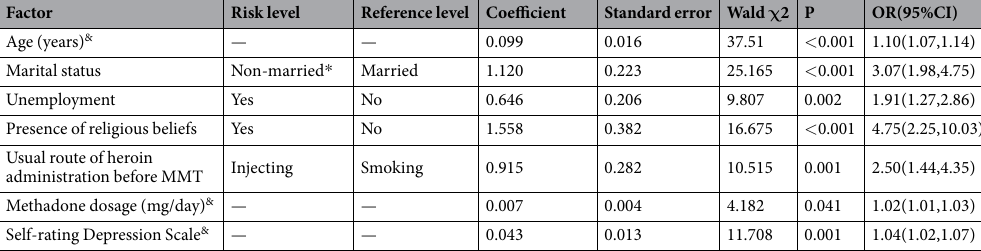
Table 2. Multivariate logistic regression results of factors significantly associated with clinically significant pain. & Continuous variables, the ORs for 1 unit increase in age (a year), methadone dose (1 mg/day), and Self-rating Depression Scale score (1 point) are 1.10, 1.02, and 1.04, respectively. * “Non-married” includes never-married, remarried, cohabitating, separated/divorced, and